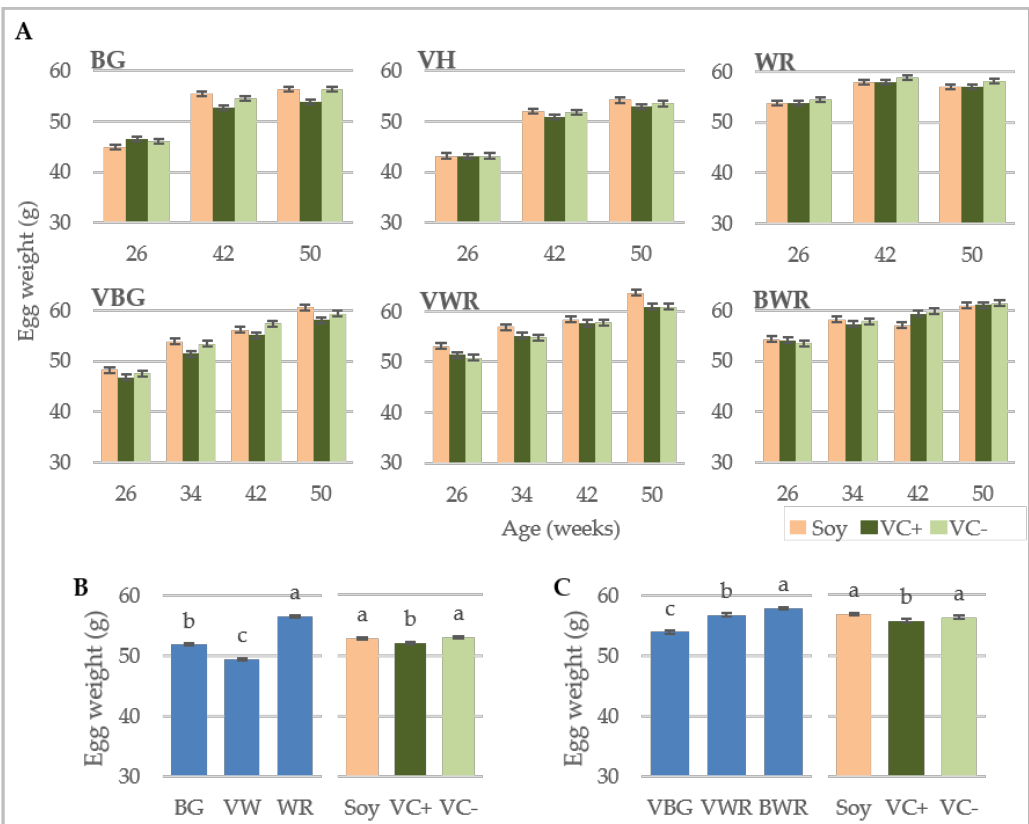
Figure 4. Egg weight. LS-means ± SE. ( A ) Effect of diet on egg weight ( n = 96). ( B ) Purebreds: Mean egg weights of the respective genotypes and diets ( n = 288). ( C ) Crossbreds: Mean egg weights of the respective genotypes and diets ( n = 288). BG: Bresse Gauloise, VH: Vorwerkhuhn, WR: White Rock, VBG: VH male × BG female, VWR: VH male x WR female, BWR: BG male × WR female. a,b,c Bars differ significantly at p < 0.05.